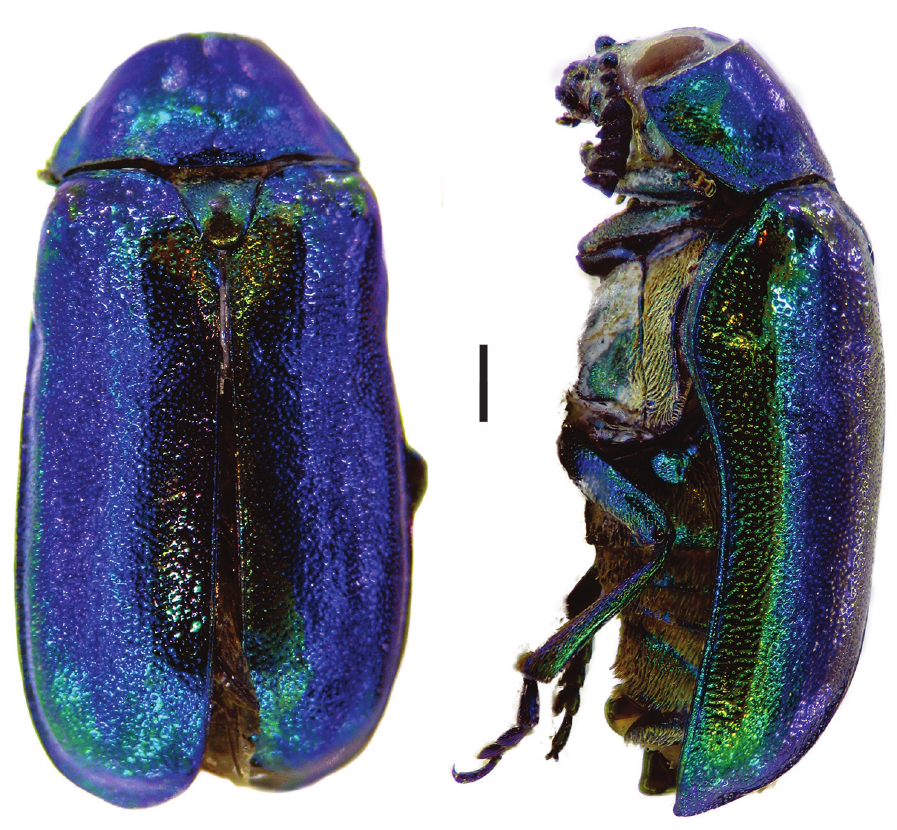
Figure 9. Helioscopa varians varians (Sahlberg) (1) , left: habitus (dorsal view), right: habitus (lateral view). Paraurodera Moldenke, 1981 Fig. 10 Paraurodera Moldenke (1981: